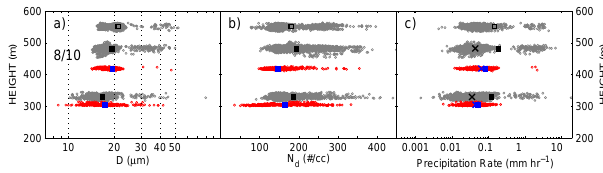
Figure 9. As in Fig. 6, but for 10 August 2011, where the cloud is initially precipitating at the time of seeding. Data obtained from pre-seeding legs are shown as grey (mean value as black square); data obtained from post-seeding legs are shown as red (mean value as blue square). Median values of drizzle rates are shown as cross symbols in (c)